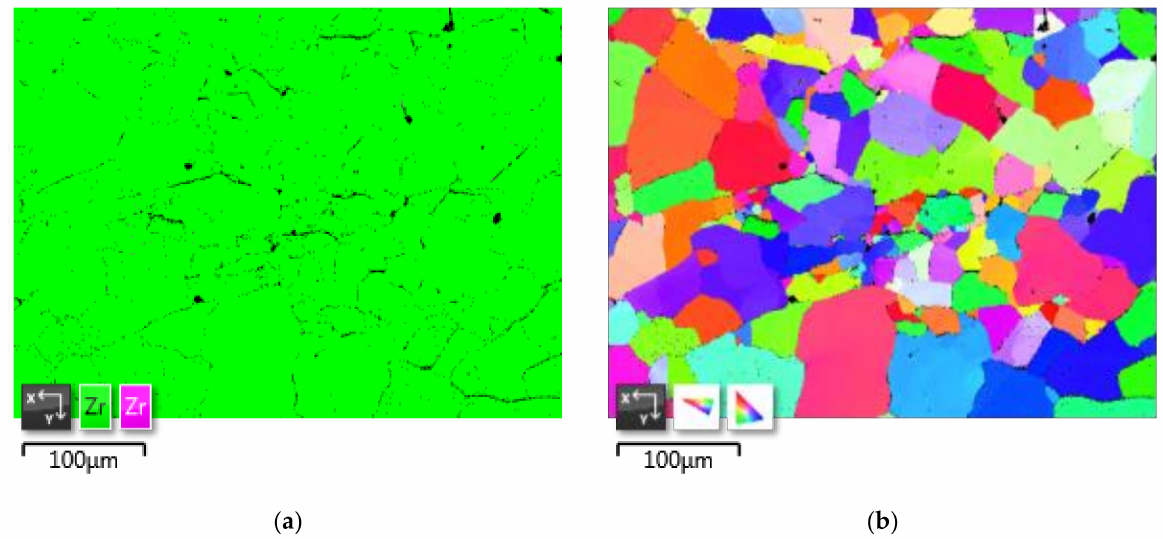
Figure 6. EBSD micrographs of zirconium spark plasma sintered at 800 ◦ C and subsequent heat treatment at 580 ◦ C with holding at 120 min: ( a ) phase map; ( b ) IPF